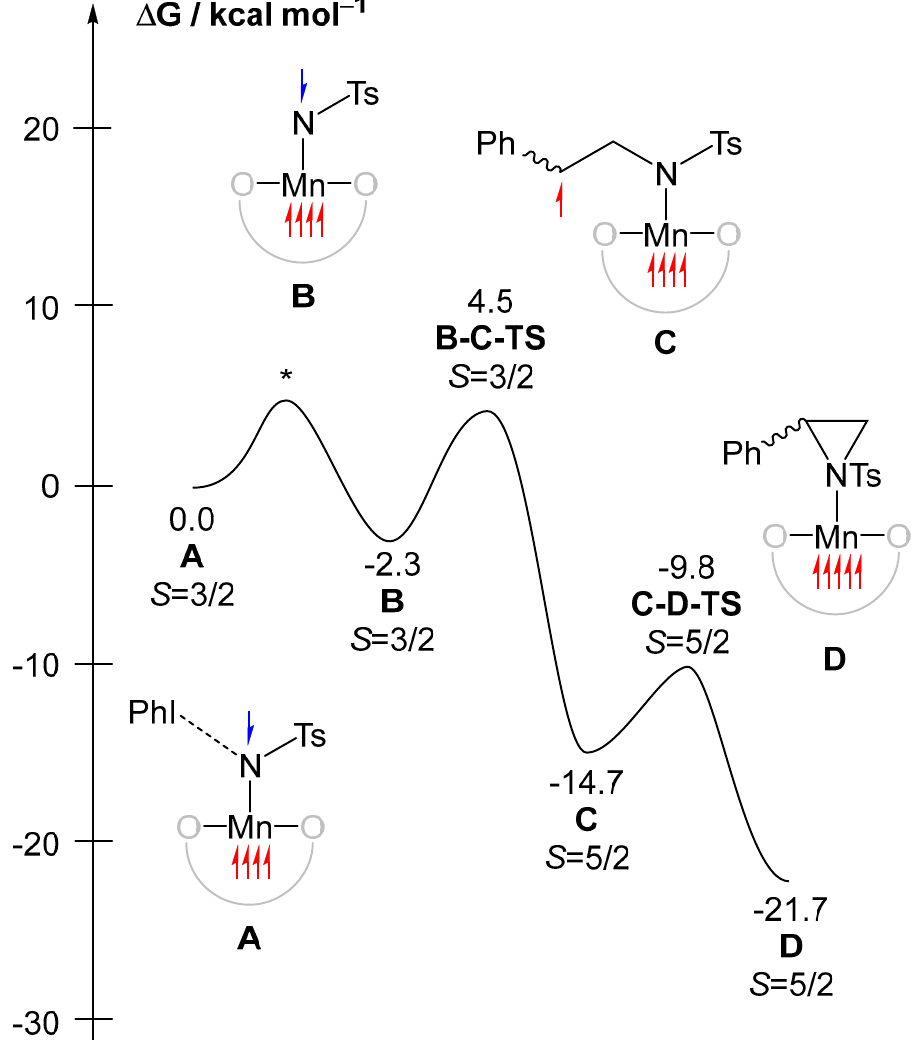
Figure 4. Reaction energy profile calculated at the B3LYP-D3(BJ)/def2-TZVP//BP86-D3(BJ)/def2- SVP level of theory. * indicates a missing transition state. Up and down spins are indicated by red and blue electrons, respectively.